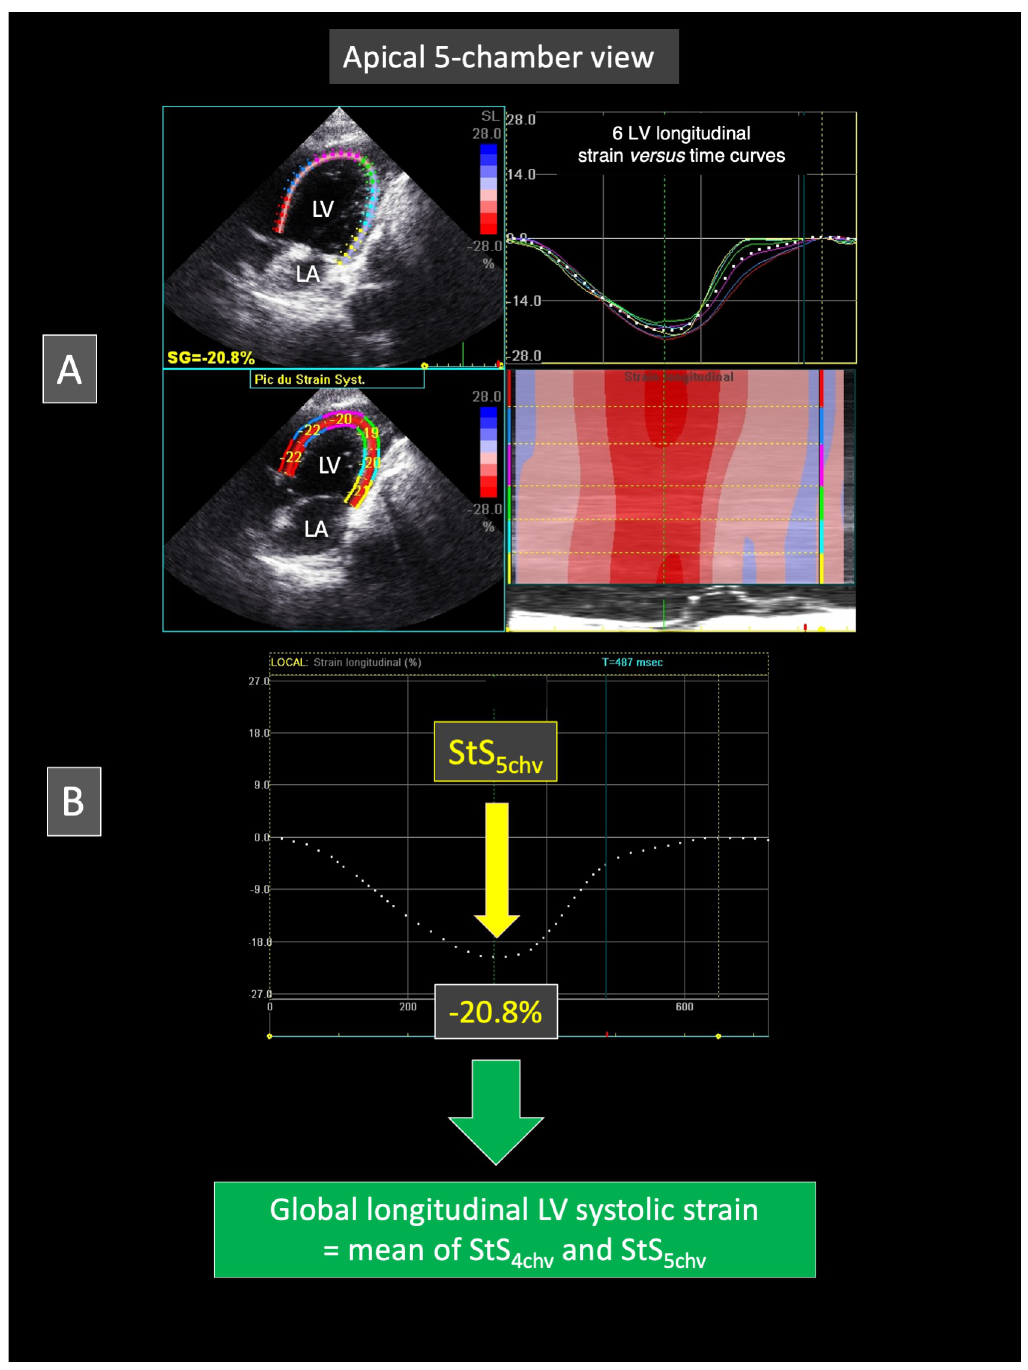
Fig 5. Representative speckle tracking imaging examination performed from the apical 5-chamber view in a Borneo orangutan. As described in Fig 3 for the apical 4-chamber view, the left ventricular endocardial border has been traced and a region of interest including left ventricular myocardial walls has been automatically drawn. Six equidistant myocardial segments have been defined. Fig A shows on the right the 6 left ventricular longitudinal strain versus time curves (corresponding to the 6 myocardial segments) during a single cardiac cycle. This representative case demonstrates that all the 6 LV segments undergo a relatively homogenous systolic myocardial shortening during systole (negative strain), with the corresponding color map below displaying the change in strain over time in each segment during the same single cardiac cycle, and with the peak systolic strain displayed in each segment on the two-dimensional color-coded view (left). Fig B shows the mean left ventricular longitudinal strain versus time curve. In this case, the peak systolic strain value (StS 5chv ) is—20.8%. The global left ventricular systolic strain